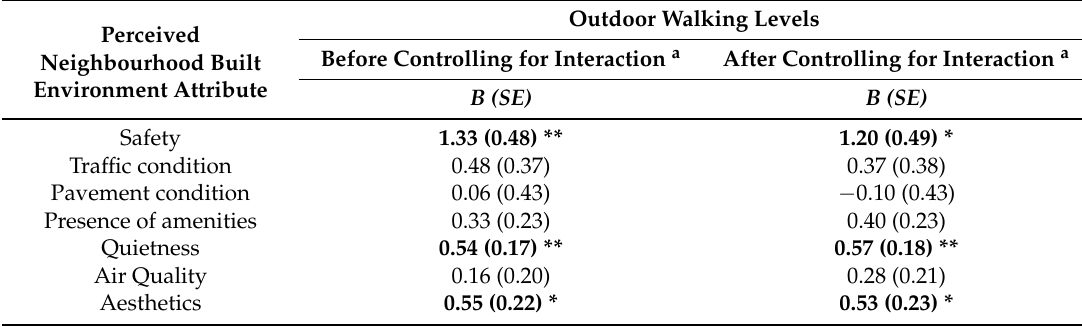
Table 5. Results of hierarchical regression analyses: relationships between perceived neighbourhood built environment attributes and outdoor walking levels.